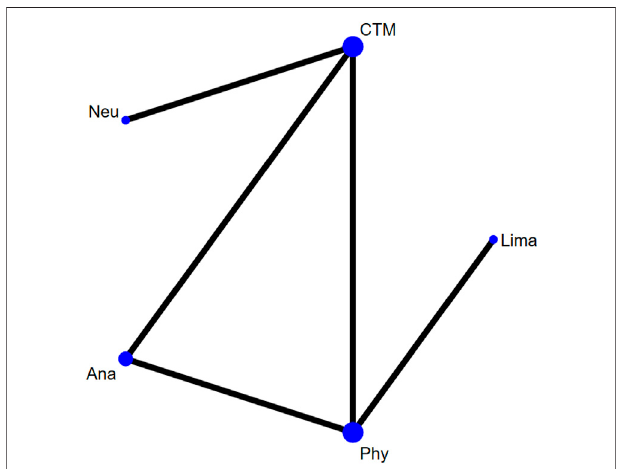
FIGURE 6 | Network plot for included studies on JOA.